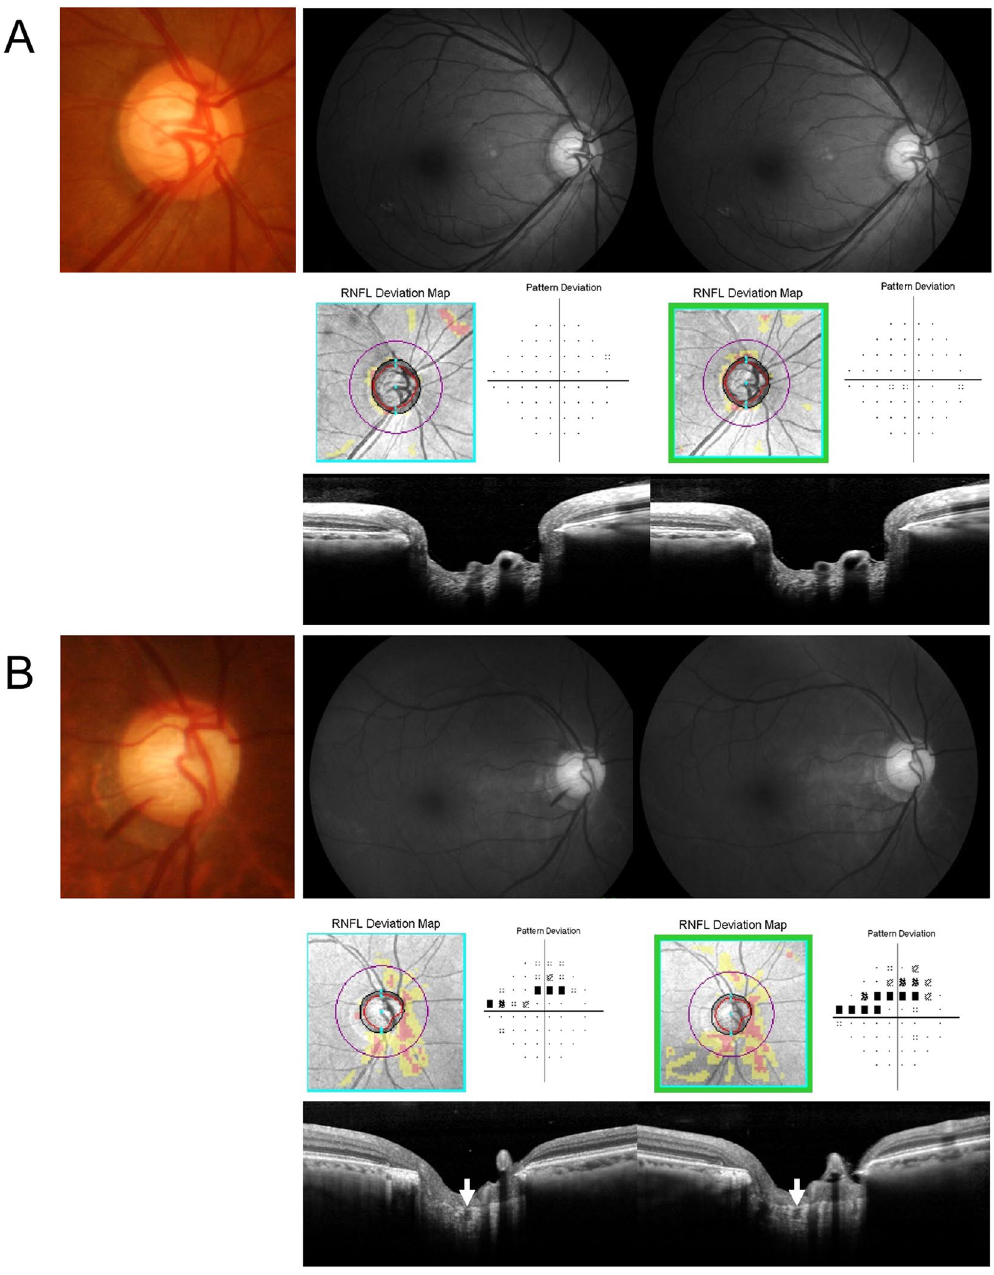
Figure 2. Representative cases. ( A ) A 56-year-old female with normal-tension glaucoma. A inferotemporal localized retinal nerve fiber layer (RNFL) defect with disc hemorrhage (DH) is shown in the right eye. Enhanced depth imaging (EDI) of the optic nerve head shows no focal lamina cribrosa (LC) defects. During five years of follow-up, there was no evidence of glaucoma progression in this case. ( B ) A 69-year-old male with normal-tension glaucoma. Diffuse RNFL defect with inferotemporal DH is shown in the right eye. Enhanced depth imaging (EDI) of the optic nerve head shows a focal lamina cribrosa (LC) defect at the site of DH. During four years of follow-up, there were progression in both the RNFL and the visual